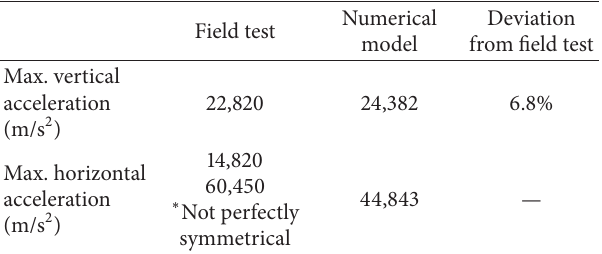
Table 6: Acceleration reading from field test and numerical model for normal concrete slab.